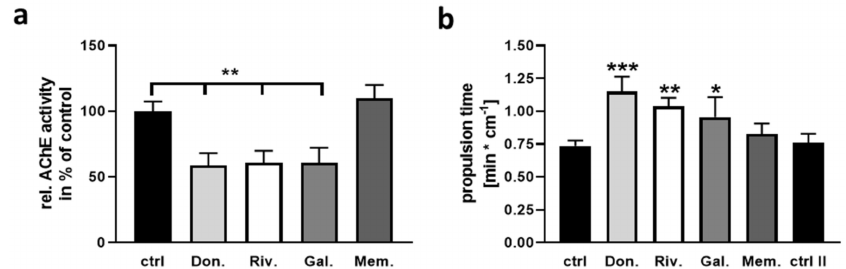
Figure 2. Assessment of colonic AChE activity and propulsion time upon application of AChEI or memantine. Pieces of proximal colon from wild type mice were dissected, cleaned, and exposed for 1 min to DMSO with a subsequent second exposure to either drug or a second DMSO application. ( a ) Enzymatic activity was measured using Ellmans reaction after propulsion time measurement in the ex vivo organ bath ( n = 6 per group with three donor mice). Propulsion time was recorded by inserting a dried fecal pellet from the respective mouse and camera-based time-lapse measurement (( b ), n = 5 per group or n = 4 (DMSO-double incubation, ctrl II)). Data are presented as mean + SEM. Statistical analysis was conducted by One Way ANOVA with Sidak’s multiple comparison test (* p < 0.05, ** p < 0.01, *** p <